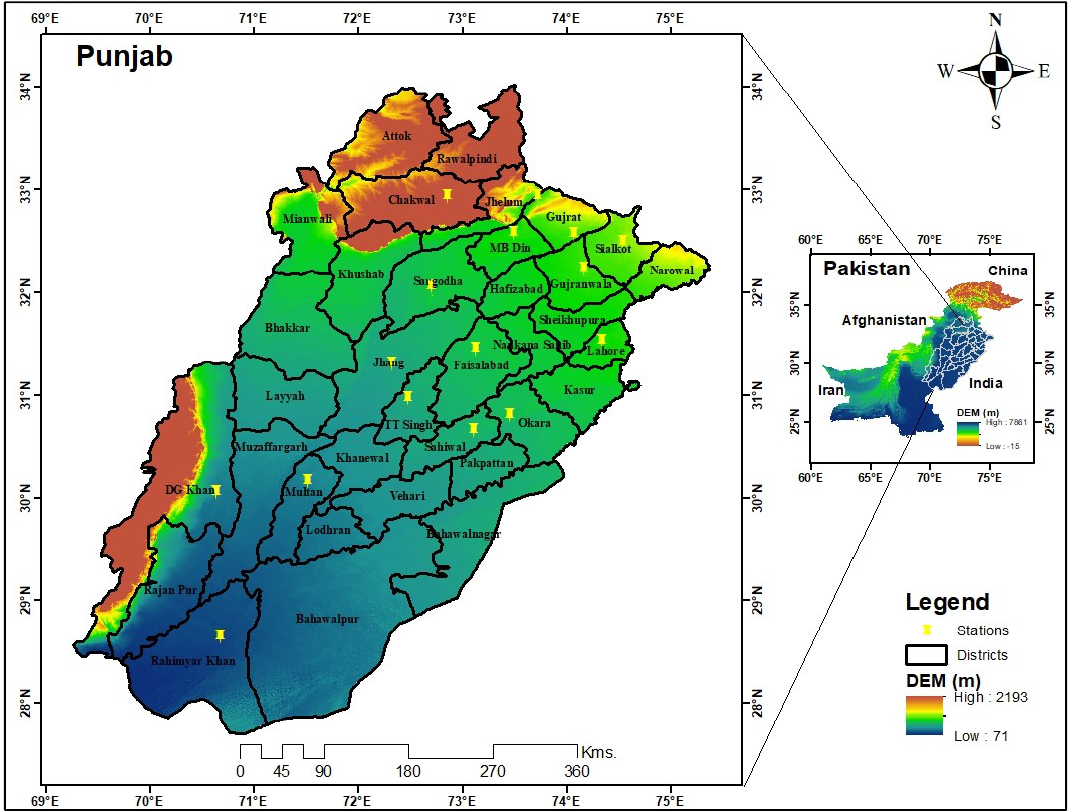
Figure 1. The map of Punjab, Pakistan, showing the districts with 16 CSFR stations.